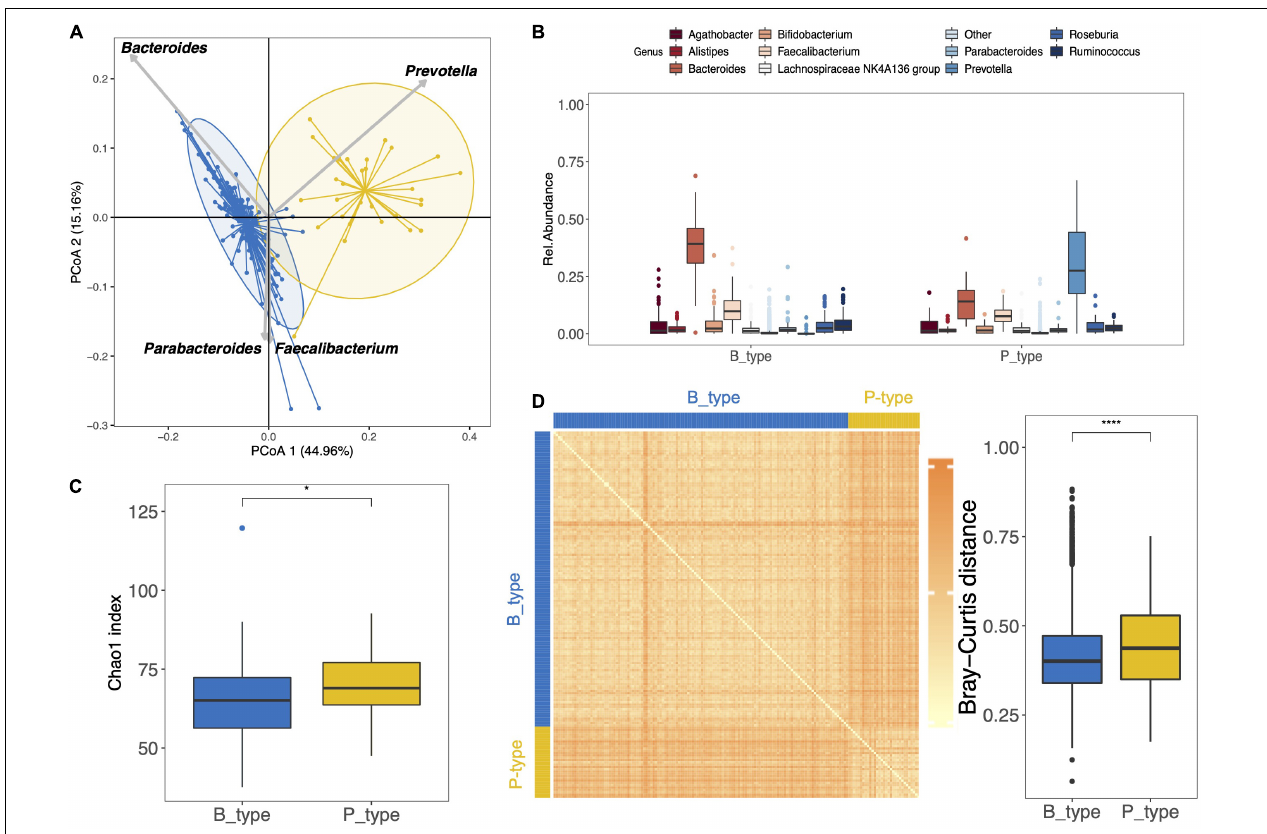
FIGURE 2 | Gut microbiota composition and diversity of the 159 preterm children at 3.5 years of age. (A) Clustering based on the genus taxonomic profile. Biplot arrows indicate the top four genera that drive samples to different locations on the plot. (B) The boxplots represent the relative abundance of the top 10 genera distributed among the P_ and B_type enterotypes. The boxplots show the smallest and largest values, 25 and 75% quartiles, the median, and outliers. (C) Boxplot of alpha diversity assessed by Chao1 estimate based on the genus taxonomic profile. (D) Inter-individual dissimilarity of the genus community based on the Bray–Curtis distance and represented by the heat map and boxplot. Each cell in the heat map, ordered according to B_ and P_type enterotypes, represents the dissimilarity level as per the color scale beside the box plot (* p < 0.05, **** p <